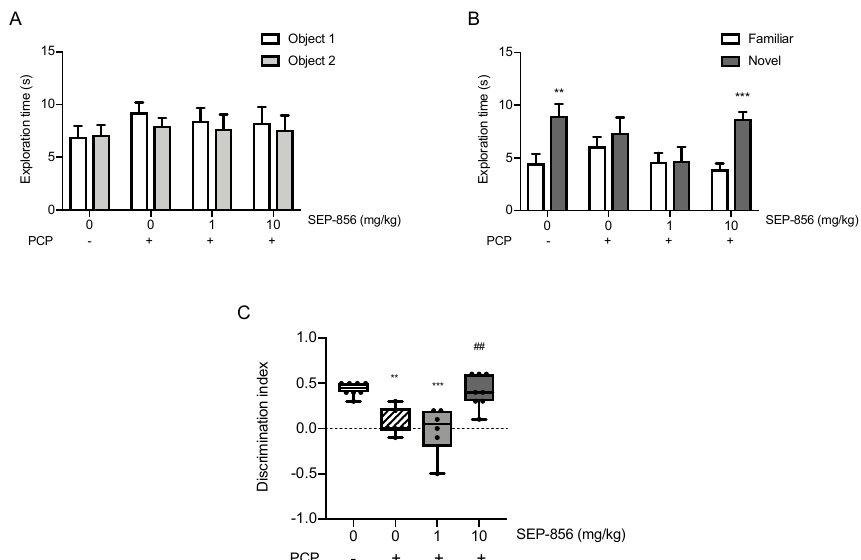
Figure 7. Effects of acute SEP-856 administration on cognitive impairment following the scPCP regimen. Time spent exploring the two identical objects in the acquisition trial ( A ). Time spent exploring the familiar and the novel object in the retention trial ( B ). ** p < 0.01, *** p < 0.001 significant differences in the time spent exploring the novel object as compared to the familiar one. Data are expressed as mean ± SEM of at least six independent determinations. NOR performance is expressed as discrimination index ( C ), representing the difference between time spent exploring novel and familiar objects during the testing phase. The data, expressed as percentage of vehicle-treated rats set at 100%, are represented as box-and-whisker plots of at least seven independent determinations. For each box, the box boundaries indicate the first and third quartiles, the middle line specifies the median and the whiskers represent the lowest and highest values. ** p < 0.01, *** p < 0.001 vs. vehicle-treated rats; ## p < 0.01 vs. scPCP-treated rats (one-way ANOVA followed by Tukey post hoc comparison).